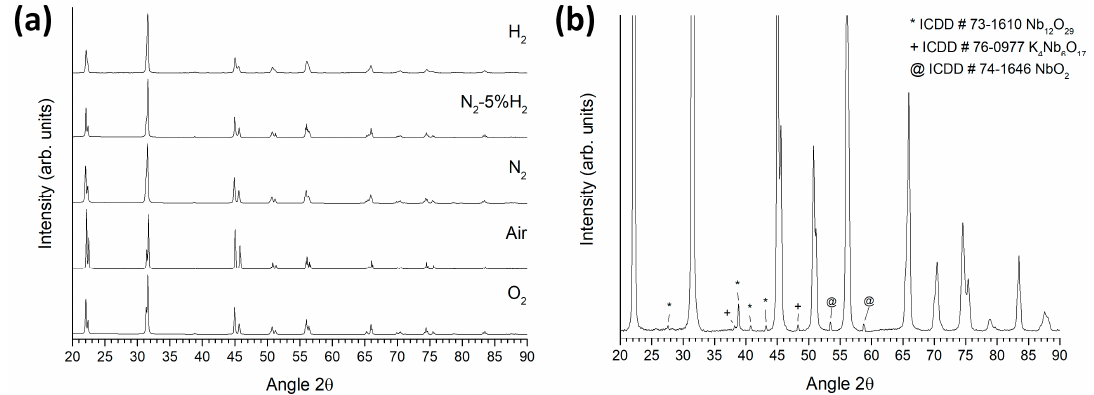
Figure 8. ( a ) XRD patterns of KNbO 3 samples sintered at 1040 ◦ C for 5 h in di ff erent atmospheres; ( b ) magnified pattern of the H 2 -sintered sample.